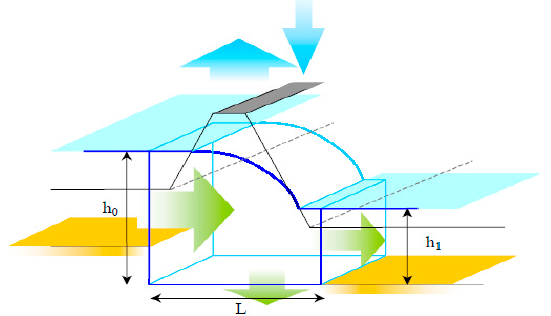
Figure 4. Schematic of the ridge lateral seepage.